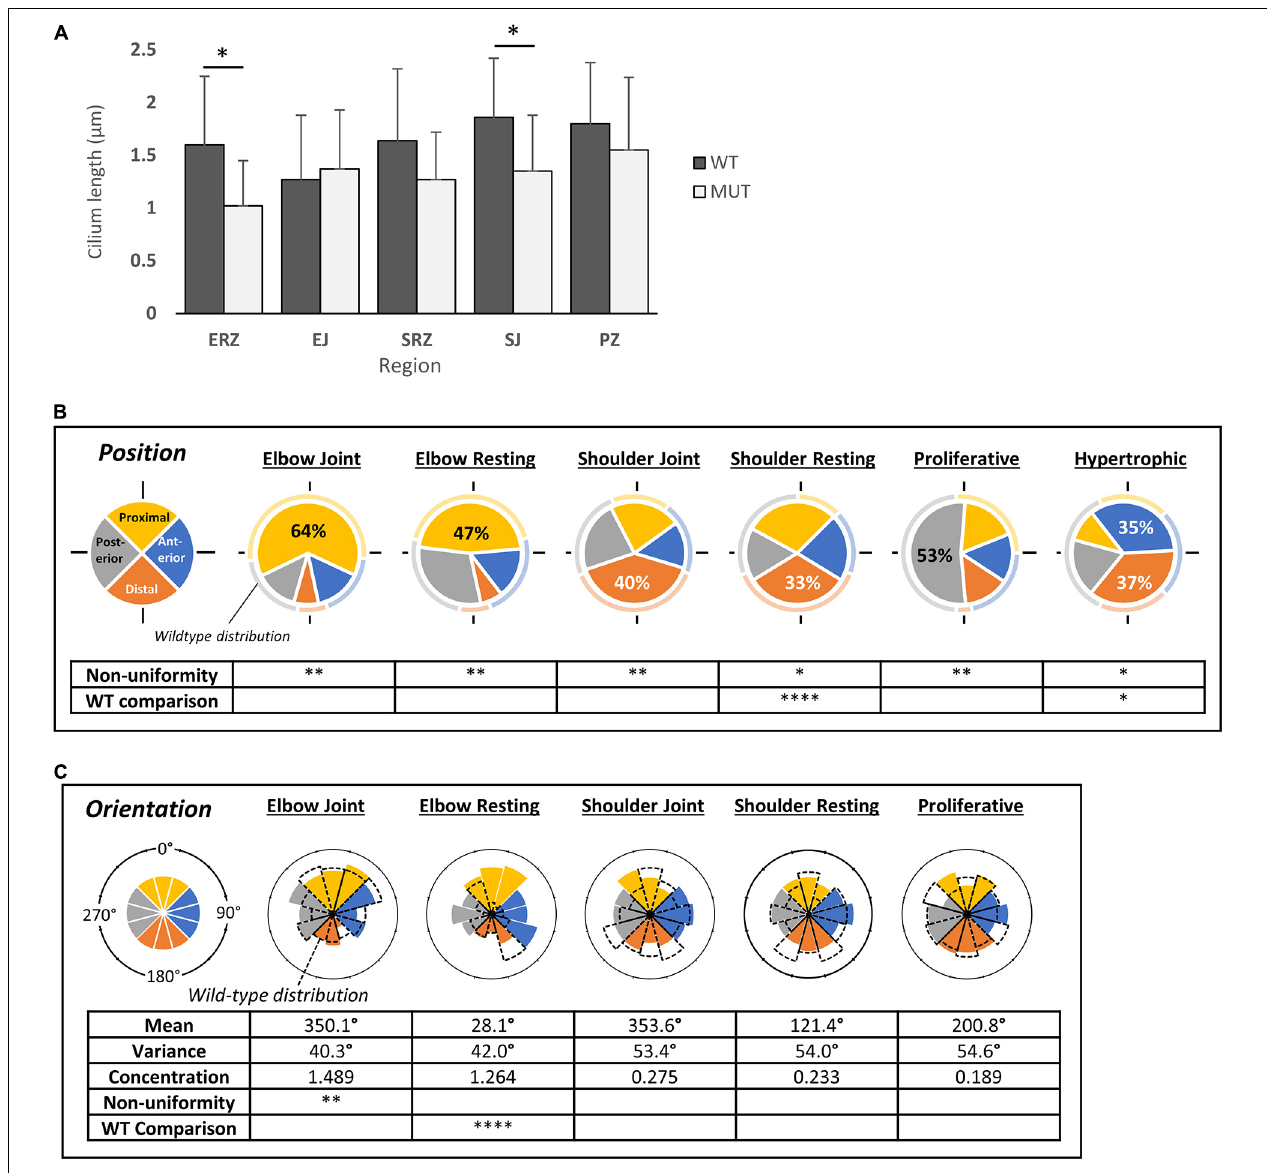
FIGURE 4 | Cilia on immobile embryo ( Pax3 Spd / Spd ) rudiment chondrocytes are shorter but have similar position of emergence and orientation compared to wildtype cilia. (A) Comparison of cilium length between wildtype (WT) and immobile mutant ( Pax3 Spd / Spd ) (MUT) across different regions of the developing humerus at TS23, as indicated. Significance was determined by paired t -tests. (B) Pie charts of cilia emergence position on chondrocytes in different regions of the mutant humerus, where each slice represents the proportion of cilia located in the given quadrant (as illustrated in Figure 1B ); color codes per named quadrant as shown on extreme left. The wildtype proportion in each quadrant for the same position is shown around each chart circumference for comparison. Significant differences from uniform distribution (non-uniformity) and from the wildtype distribution (WT comparison) are shown (chi-squared tests). (C) Rose histograms of cilium axoneme orientation on chondrocytes in different regions of the mutant humerus; for comparison the wildtype pattern is shown as dashed outlines. Angular mean and variance, concentration, and non-uniformity were calculated as for wildtype ( Figure 3B ). Values for WT (wildtype) comparison represent the results of Mardia-Watson-Wheeler/Uniform Scores tests, as calculated using the CircStats package in R. Significance values: ∗ p < 0.05, ∗∗ p < 0.01, ∗∗∗∗ p < 0.001. N = 4 independent wildtype specimens and n = 3 independent mutant specimens; except n = 3 and n = 2, respectively, for length